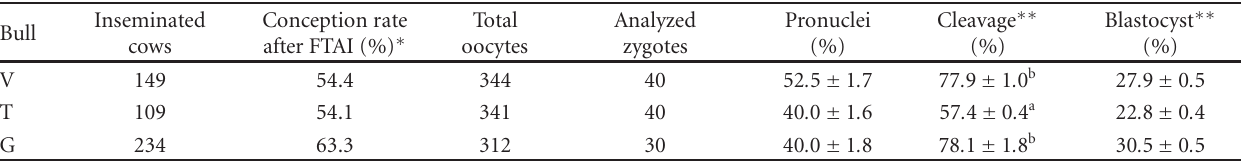
Table 1: Fertility performance of each bull expressed as conception rate after fixed-time artificial insemination (FTAI). Pronuclei visualization, cleavage rates, and blastocyst formation rates (means ± SD) observed at 12, 72, and 168 hours after in vitro fertilization,